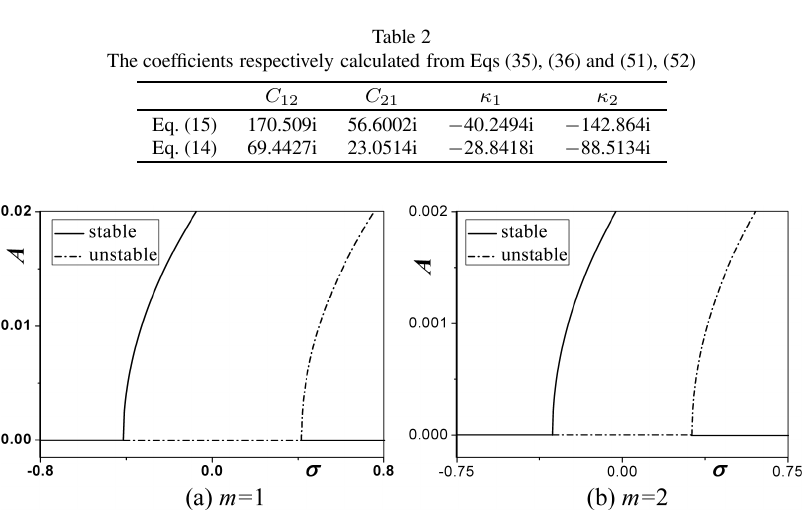
Fig. 1. Amplitudes and stability of steady-state responses: Eq. (15).